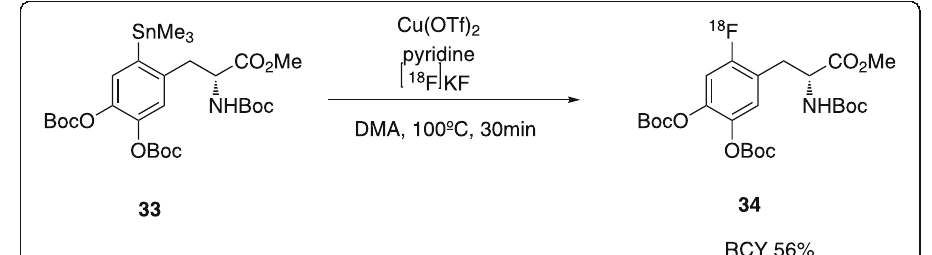
Fig. 12 Cooper-mediated synthesis of protected 6-[ 18 F]fluoro-3,4-dihydroxy- L -phenylalanine (Makaravage et al.,